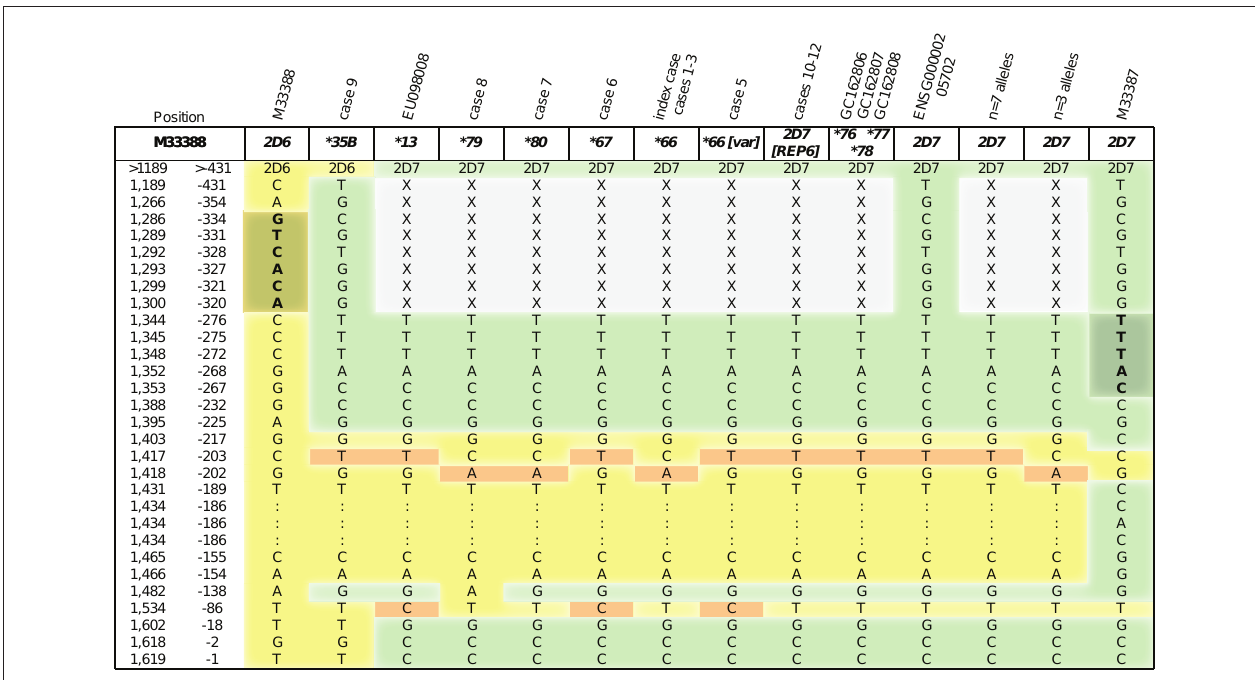
primer binding site for fragment H is shown in darker green in the M33387 reference sequence and limits the sequence information obtained from the hybrids (X denotes no sequence). A commonly used CYP2D6 -specific primer binding site is shown in darker yellow in the M33388 reference sequence. For CYP2D6 * 35B ∼ 1.5 kb of upstream region was